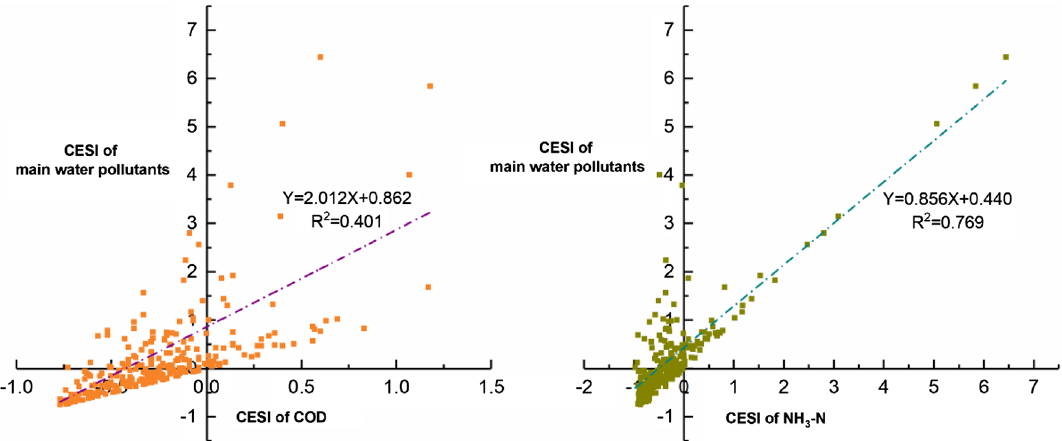
Figure 6. Scatter plot of the CESI of particular pollutants and main water